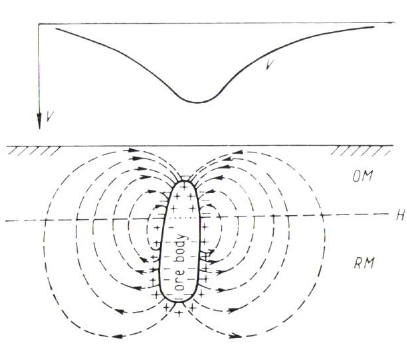
Figure 7. The generation of natural electrochemical fields in the neighbourhood of an ore body (by Mareš 1984)